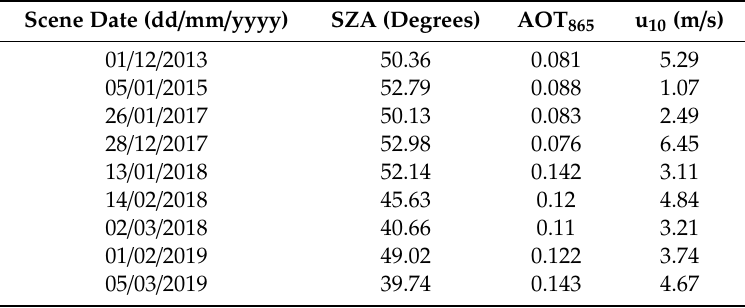
Table 1. Environmental parameter variables for each image. AOT 865 : Aerosol Optical Thickness (AOT) at 865 nm, SZA: Solar Zenith